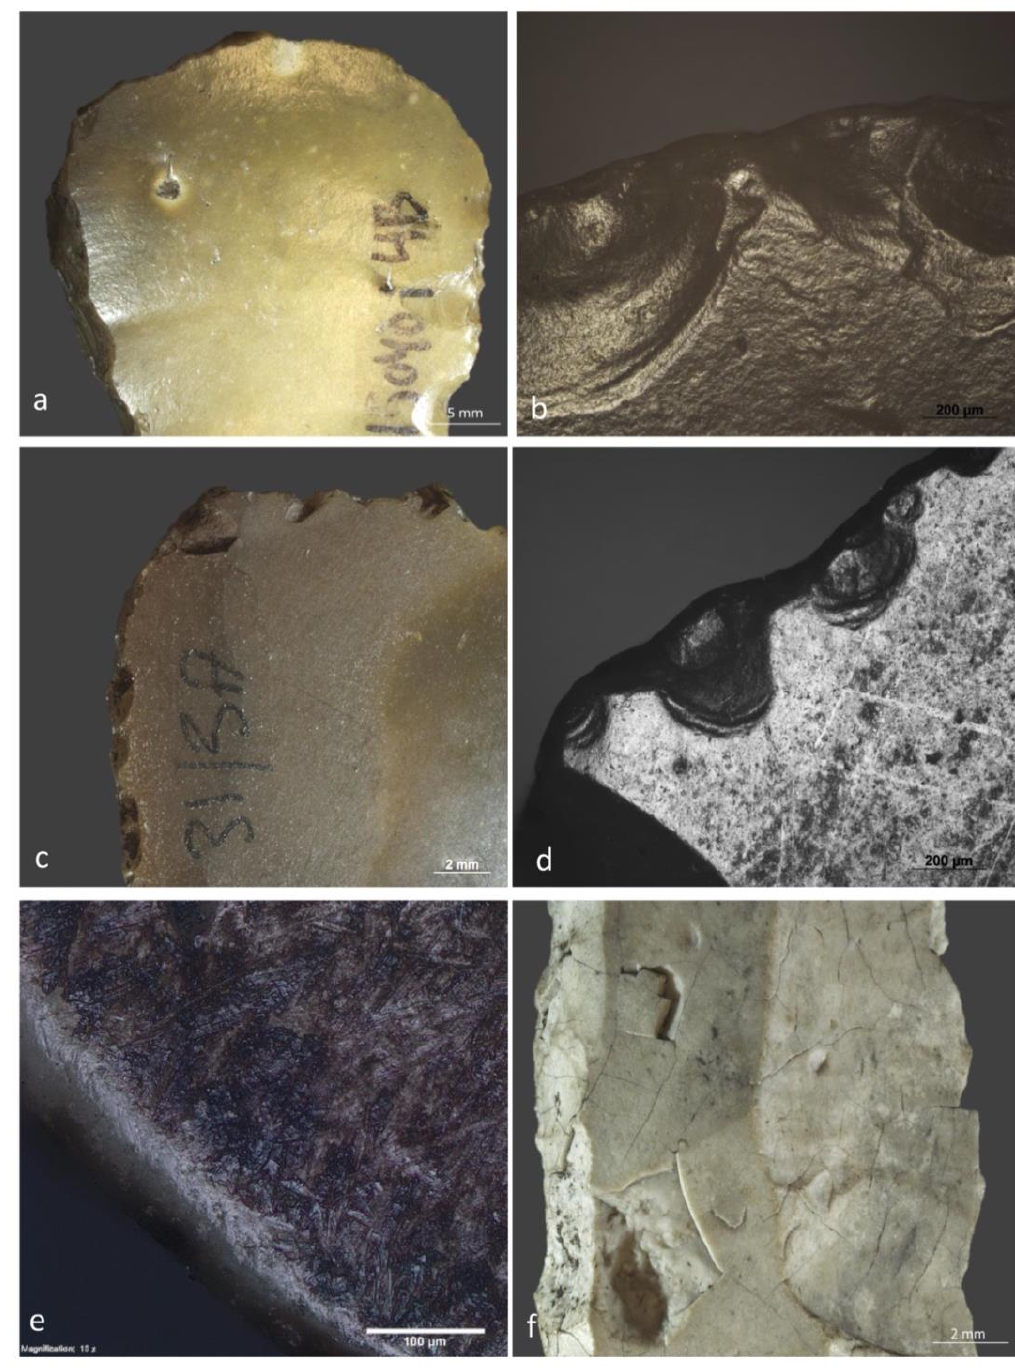
Figure 2. Macro and microscopic images illustrating the differential preservation as a result of taphonomic processes: a) distal part of scraper LB25_9 (6.3x) with heavy surface gloss and edge rounding; b) microscopic detail of the rounded edge and surface gloss of artefact LB38_1104 (100x); c) post-depositional edge scarring on the distal edges of piece LB25_54 (12.5x); d) microscopic detail of heavily developed surface gloss, striations and edge rounding on piece LB25_46 (100x); e) microscopic detail of the surface of the piece LB25_47 (100x) that is covered with a residual deposit and curved striations with diverse orientations; f) macroscopic detail of the heat-altered piece LB25_117 (16x) showing negatives, cracks, fissures and heavy